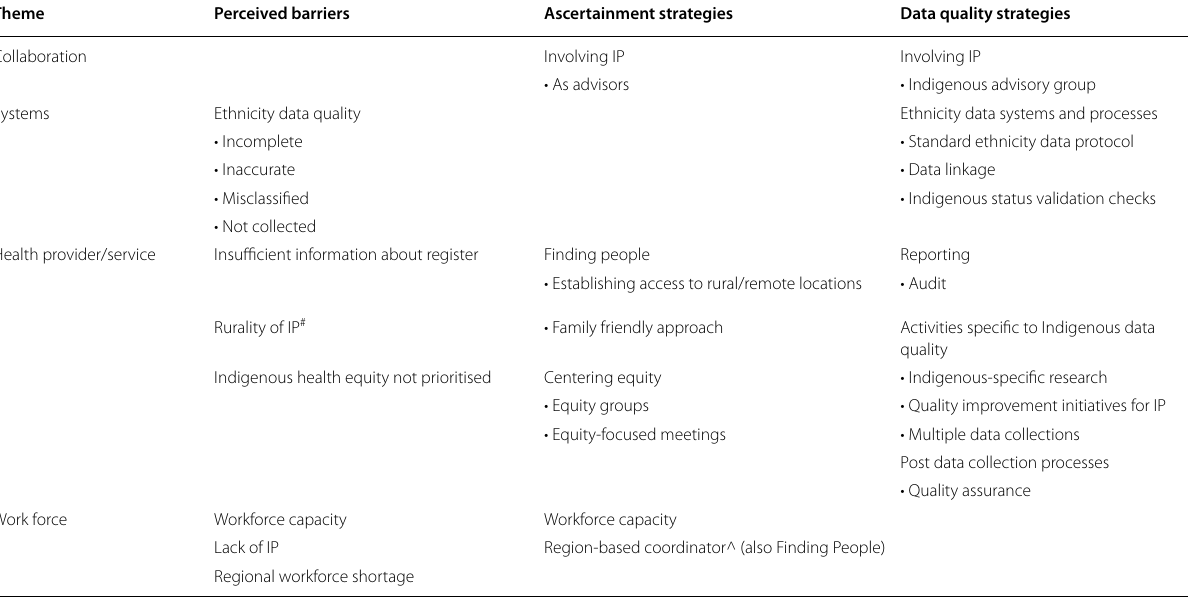
IP Indigenous peoples = # “Rurality of IP” refers to respondent perceptions that Indigenous peoples are predominantly a “rural population base” ^ “Region-based coordinator” refers to placing “a coordinator in [a specific] region recognising a large number of [Indigenous] families with [the health condition] were located